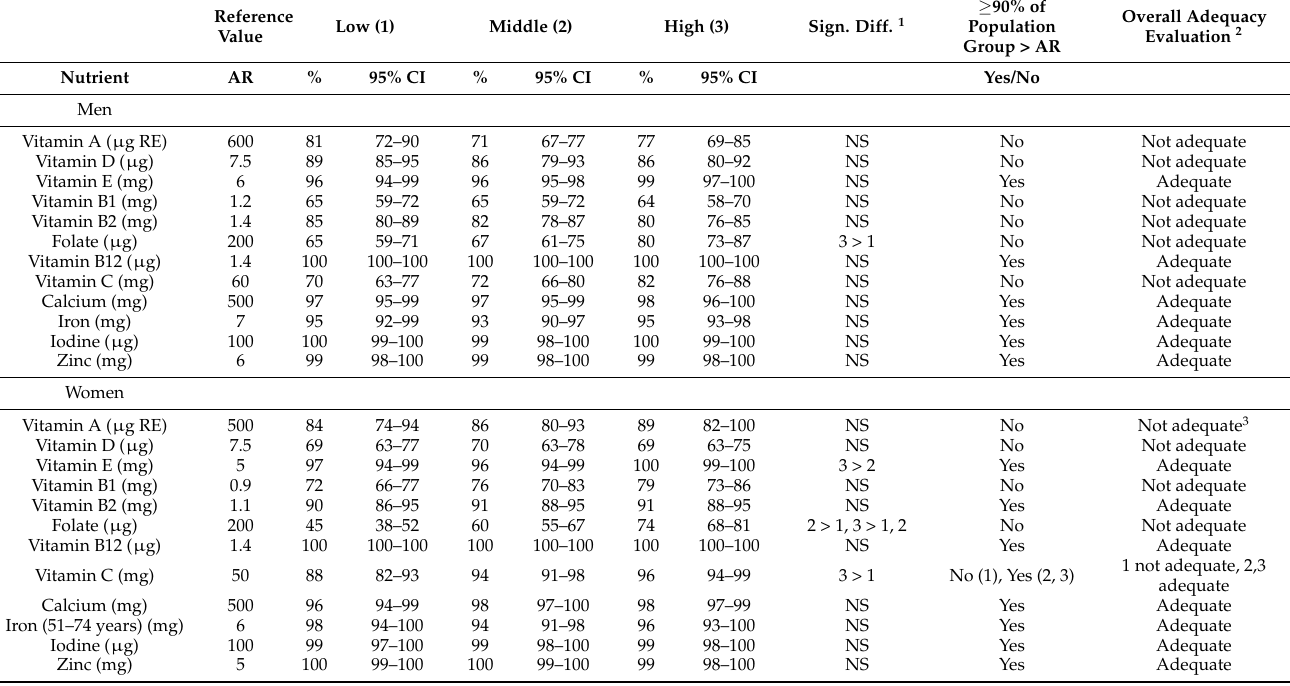
Table 4. Proportion of population groups reaching the average requirement (AR) values, and adequacy evaluation based on usual intake distributions in men and women by